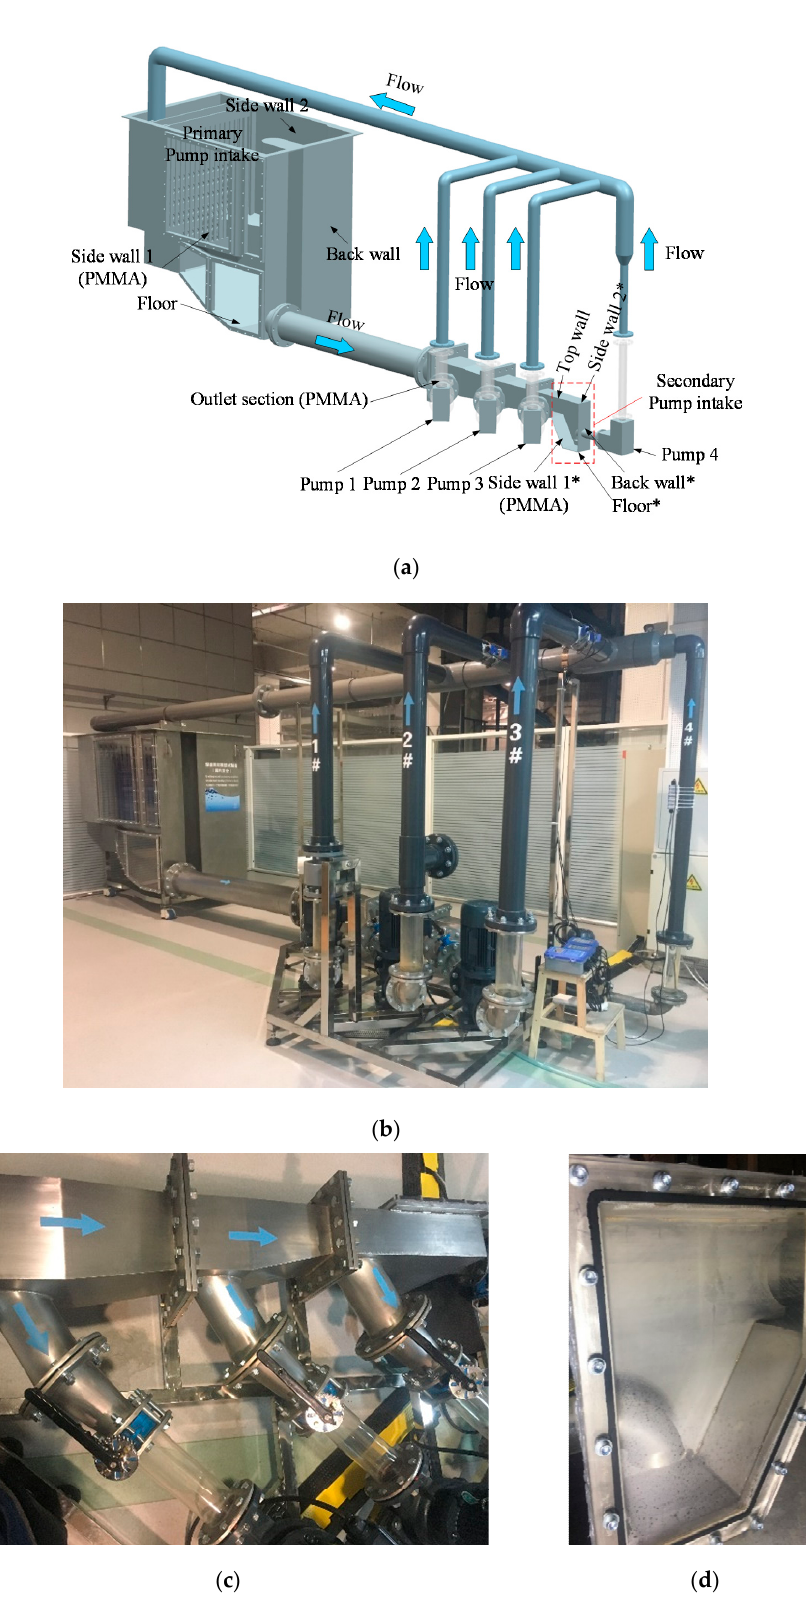
Figure 3. The experimental facility. ( a ) 3D model (the asterisk indicates the secondary pump intake), ( b ) circulation loop, ( c ) connection between the branch and main pipes of pump 1–3, ( d ) secondary pump intake.